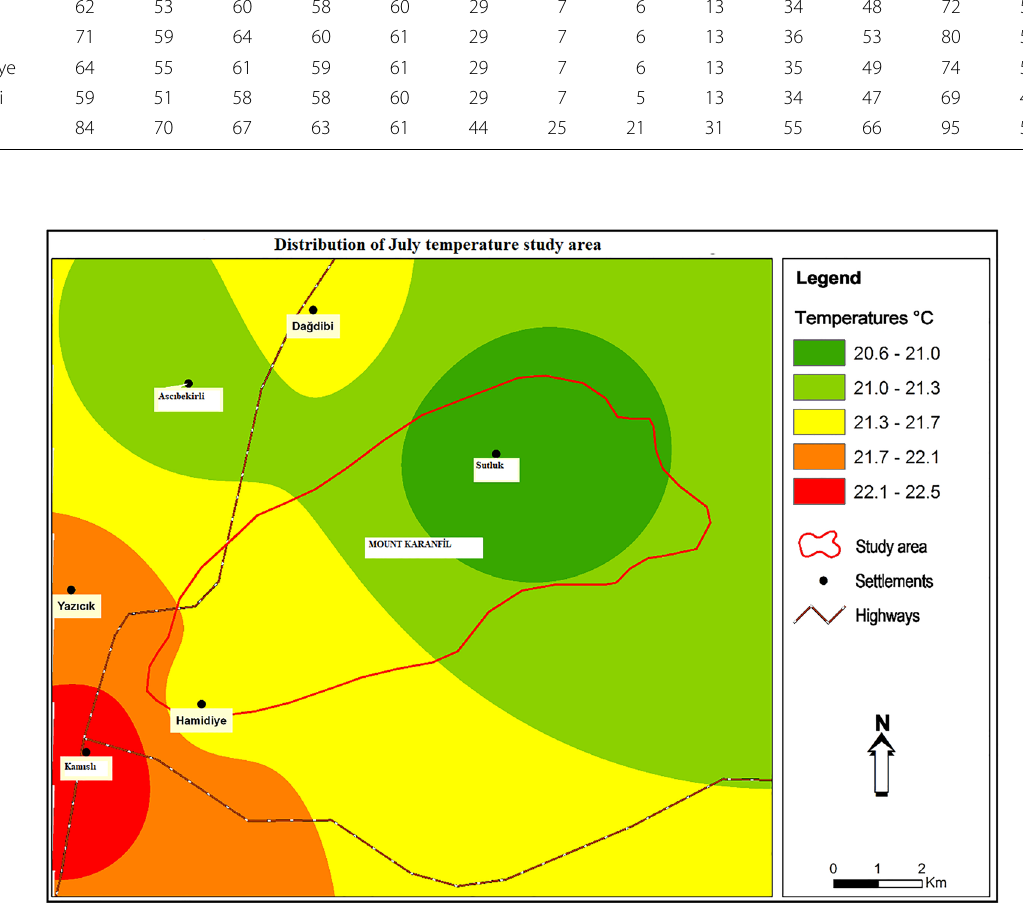
Fig. 12 Distribution of July temperature study